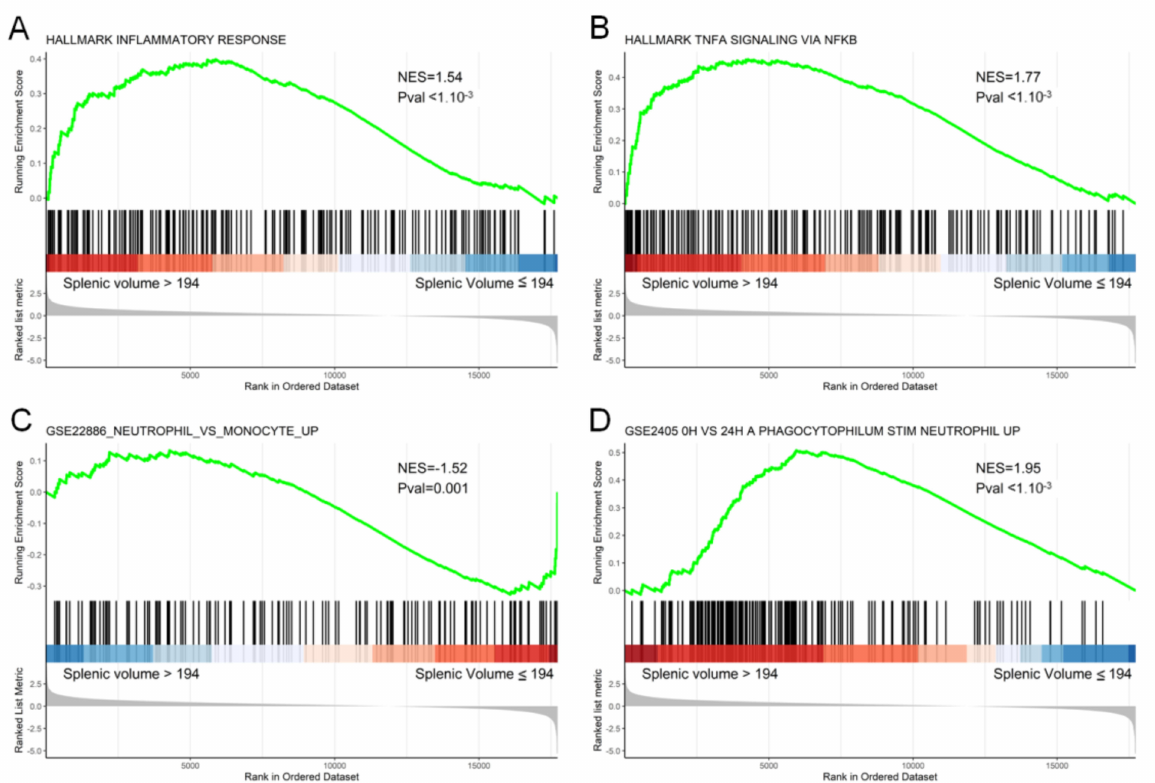
Figure 4. Gene set enrichment analysis (GSEA) enrichment plot for the proliferation of the inflammatory response ( A ), TNFA ( B ), neutrophil vs. monocyte ( C ) and phagocytophilum stim neutrophil ( D ) pathways at 24 h. The y-axis represents enrichment score (ES) and the x-axis shows genes (vertical black lines) represented in different pathways. The colored band at the bottom represents the degree of correlation of the expression of these genes (red for a high gene expression and blue for a low gene